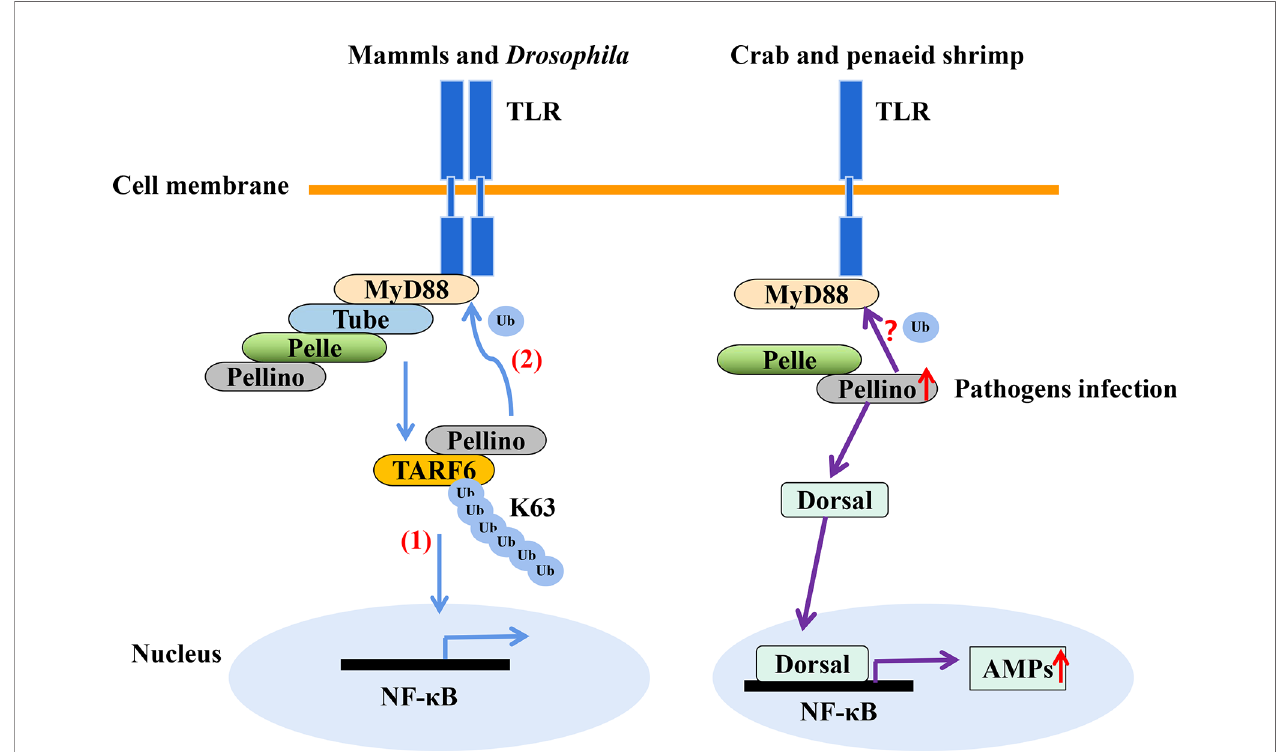
FIGURE 4 | The E3 ubiquitin ligase Pellino plays a positive role in shrimp antibacteria response. Pellino acts as a conserved scaffold protein and E3 ubiquitin ligase in the TLR signaling pathway. (1) Pellino promotes the K63-linked ubiquitination of TARF6 (88). (2) In addition, Pellino can ubiquitinate MyD88 for degradation to negatively regulate TLR signaling and maintain innate immune homeostasis (89). Pellino can also interact with Pelle in shrimp. The expression of Pellino is up- regulated upon pathogens stimulation, and to increase the activity of Dorsal, thus enhancing AMPs expression with V. parahaemolyticus challenge (85), in which Dorsal is also involved in defense against gram-positive bacterial in S. paramamosain (90). However, the ubiquitinated substrates of Pellino in shrimp (such as whether MyD88 is ubiquitinated) is currently